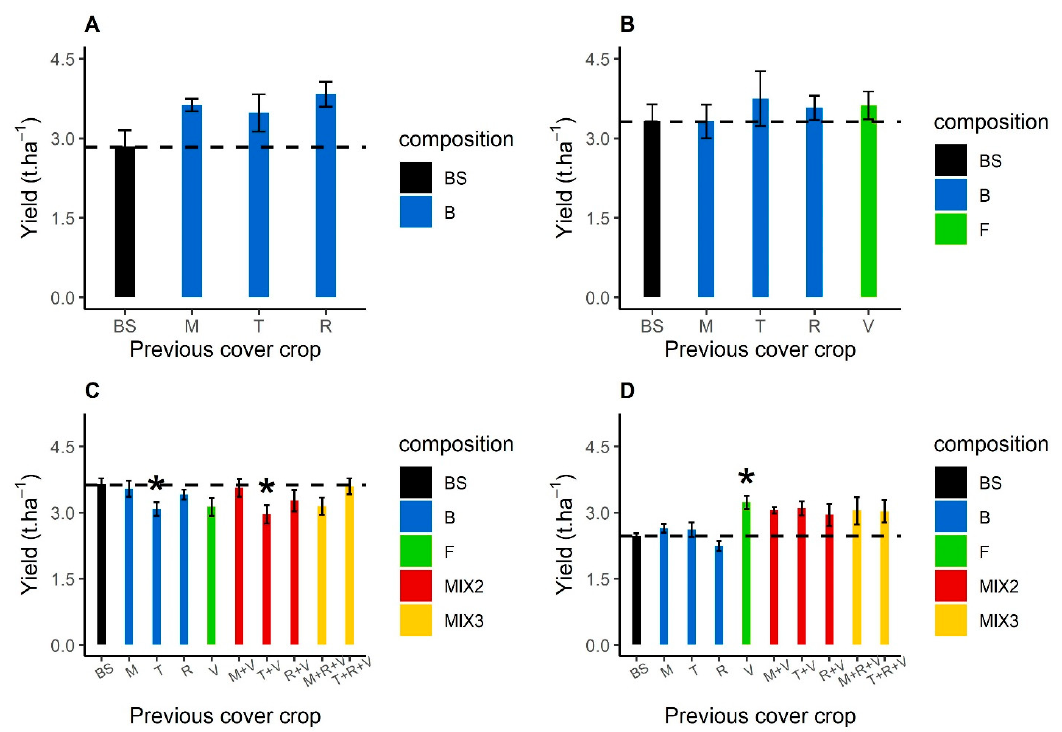
Figure 6. Manual sunflower yields (t ha − 1 ) from the sunflowers monitored for sunflower verticillium wilt severity after bare soil, Brassicaceae or Fabaceae cover crop in 2016 ( A ), 2017 ( B ), 2019 ( C ) and 2020 ( D ). The yield after a bare soil is in black, blue after Brassicaceae ( B ) sole crops, green after Fabaceae (F) sole crops, red for a mixture with one Brassicaceae and one Fabaceae (MIX2), and orange for a mixture with two Brassicaceae and one Fabaceae (MIX3). In 2019, the turnip rape did not grow in the mixture with fodder radish and purple vetch. Abbreviation letters refer to the treatment with BS for bare soil, B for Brassicaceae, F for Fabaceae, M for brown mustard, T for turnip rape, R for fodder radish and V for purple vetch. Dashed lines indicate the mean bare soil yield for the year. Error bars represent standard errors. Treatments with yields that differ significantly from that of bare soil are indicated by * ( p < 0.05).